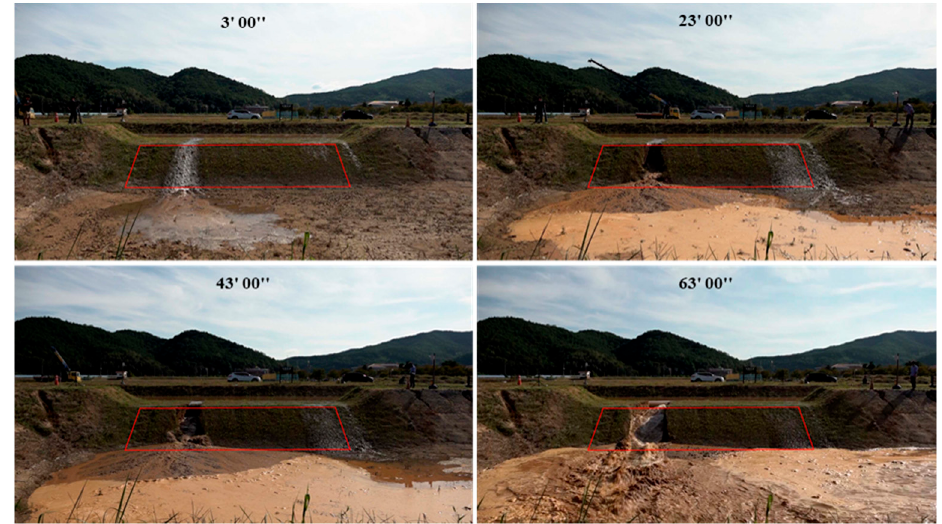
Figure 9. Levee collapse pattern over time immediately after overtopping (Case 2).